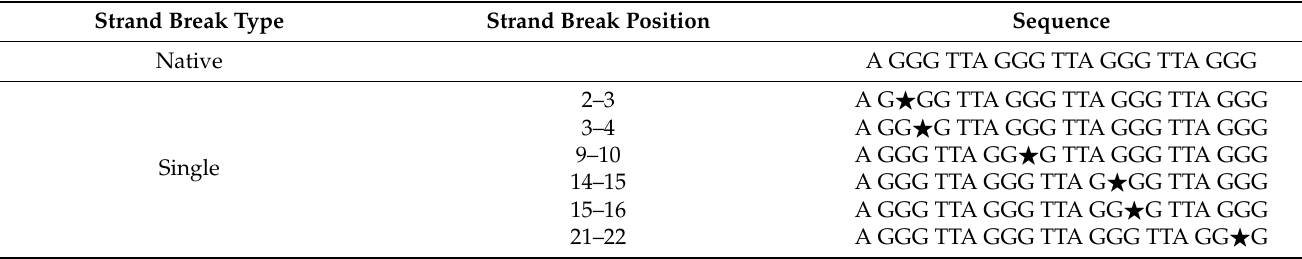
Table 1. Schematic representation of the positions of the considered strand breaks. as indicated by the symbol (cid:70) . CA and NC strand breaks occur on the two O-P(O2)-O sides of the same phosphate group. Strand Break Type Strand Break Position Sequence